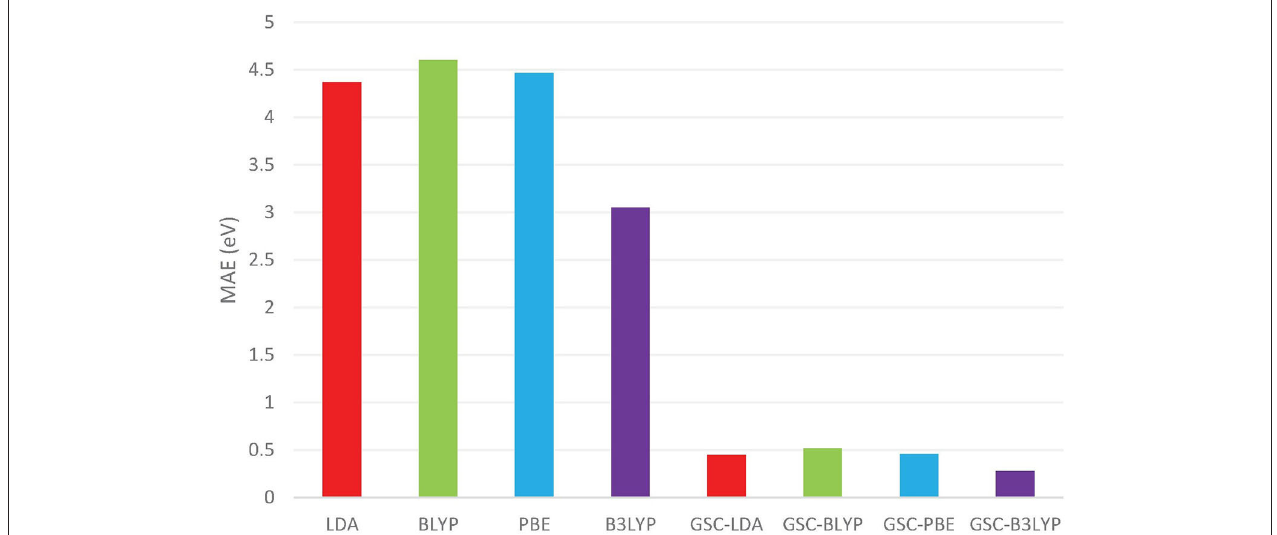
FIGURE 1 | The mean absolute errors (MAEs) (in units of eV) between the occupied Kohn–Sham (KS)/generalized KS (GKS) orbital energies { ε i } calculated by various density functional approximations (DFAs) and the experimentally measured quasihole energies { ω i } . The experimental data are extracted from Chong et al. (2002) and Schmidt (1977). The basis set adopted in the density functional calculations is aug-cc-pVTZ (Kendall et al., 1992; Woon and Dunning Jr, 1993).